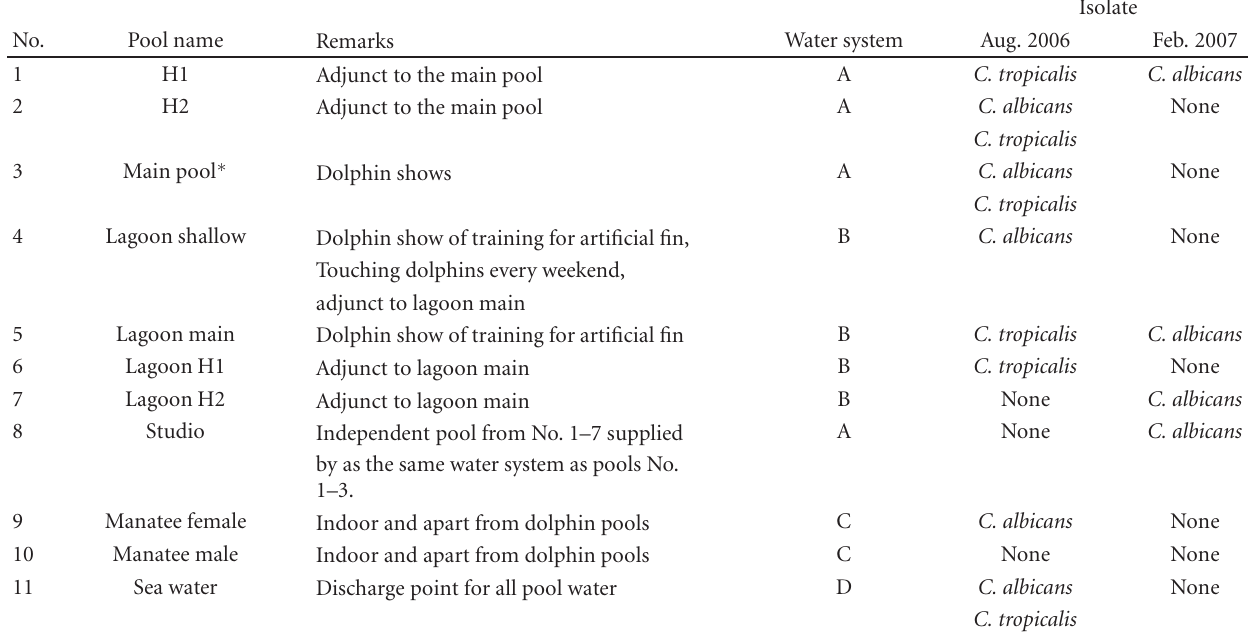
Table 4: Pools and seawater.